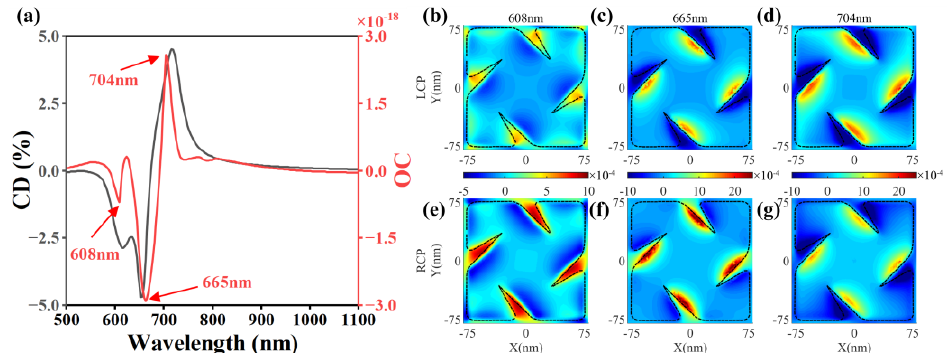
Figure 3. ( a ) CD spectra (black line) and OC integral spectra (red line) of single GHNP when side length l = 150 nm. These two spectra exhibit a clear correspondence. The red arrows mark out three resonance positions. ( b – g ) The OC distribution on integral surface at each resonance position (608 nm, 665 nm, and 704 nm) with LCP incidence ( b – d ) and RCP incidence ( e – g ).